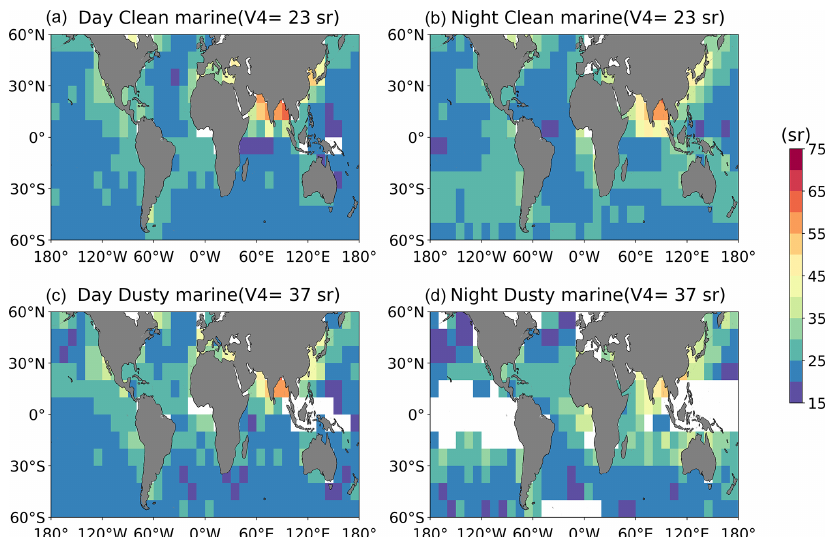
Figure 12. Median CALIPSO–SODA lidar ratio as in Fig. 8 but for clean marine (a, b) and dusty marine (c, d) classified from 5km spatially averaged data and gridded at 10 ◦ × 10 ◦